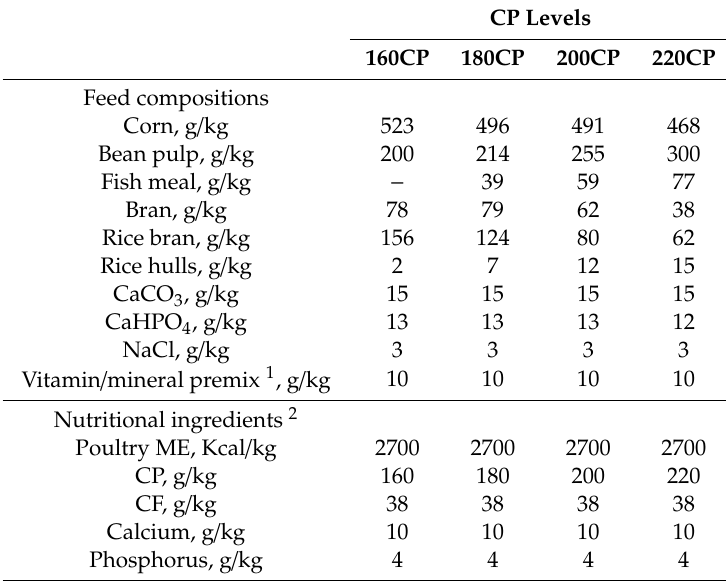
Table 1. Composition of experimental diets in Experiment